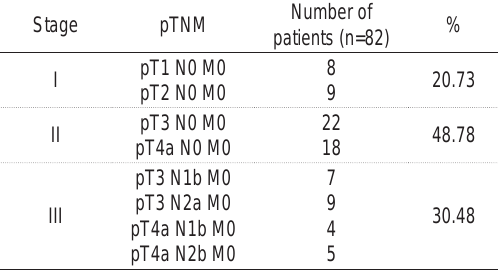
TABLE 1. Staging of the disease in CRC patients